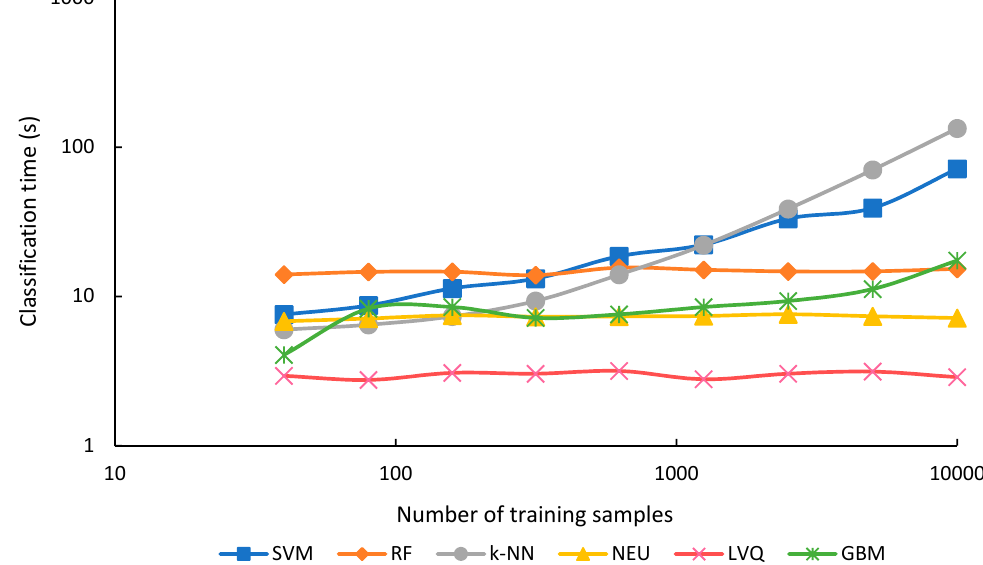
Figure 9. Classification time in seconds and training set size. Please note that the x- and y-axis are on a log scale.